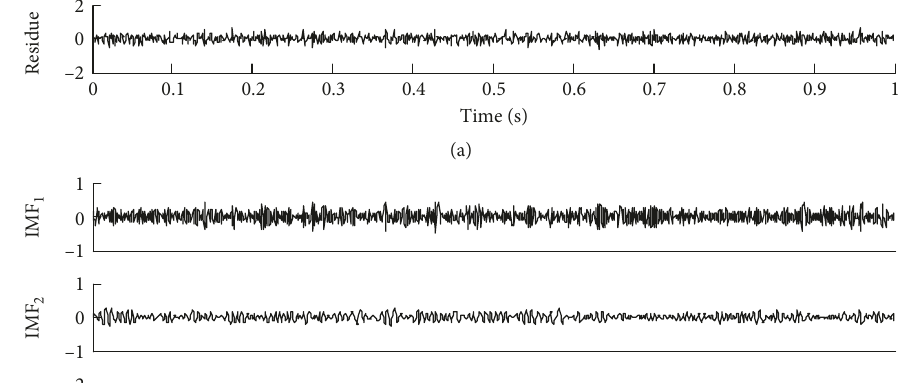
2 ( n ) shown in Figure 6(b) (SNR (cid:29) 10). The